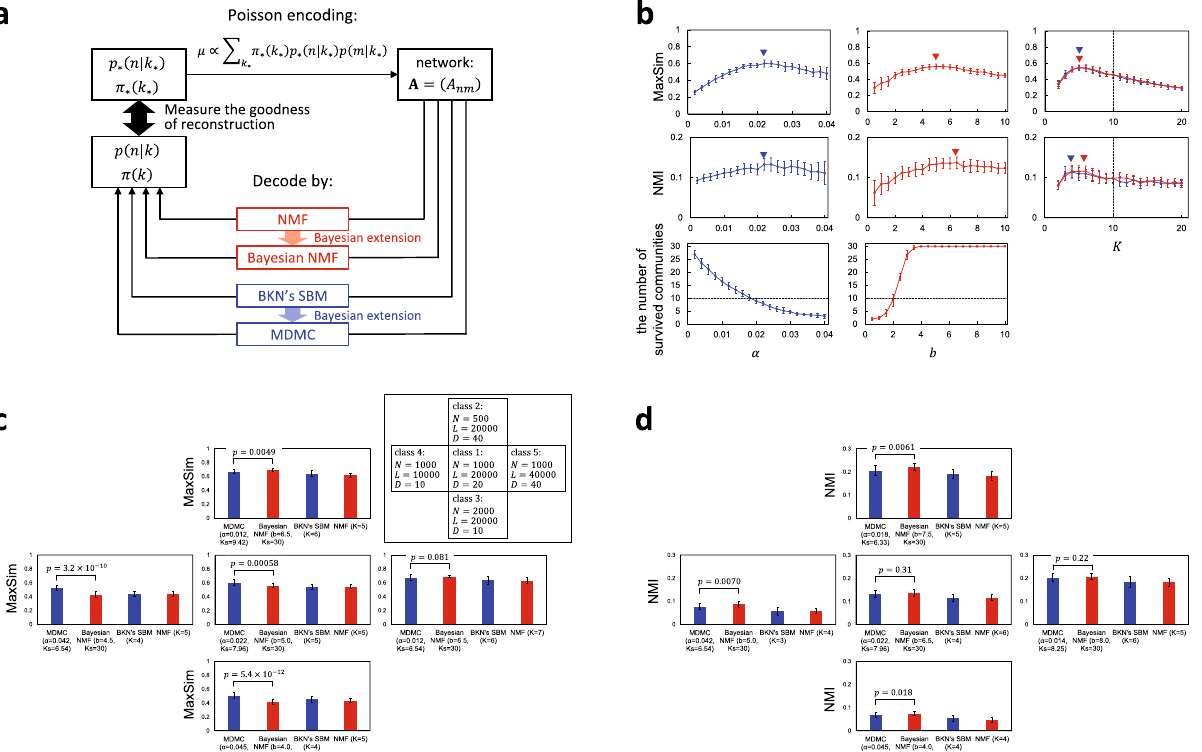
10 Figure 3. The performance of community detection from benchmark networks planted with K ∗ = pervasive communities was compared between MDMC, Bayesian NMF, BKN’s SBM and NMF. ( a ) Schema of our comparative experimental procedure. ( b ) Results for pervasive community detection from benchmark 1000 nodes and L 20,000 undirected links, whereby the density D 20 ). L / N networks of class 1 ( N = = = = MaxSim, NMI and the number of survived communities calculated by MDMC and Bayesian NMF are plotted as functions of α and b in panels of the left and centre columns, respectively. MaxSim and NMI calculated by BKN’s SBM (blue) and NMF (red) are plotted as function of the predefined number K in panels of the right column. Filled inverted triangles in panels of the top and middle rows indicate peak MaxSims and NMIs. Horizontal dashed lines in panels of the bottom row and vertical dashed lines in panels of the right column 10 of planted pervasive communities. ( c ) Peak MaxSims are compared indicate the true number K ∗ = between MDMC, Bayesian NMF, BKN’s NMF and NMF. The centre, top, bottom, left and right panels show 1000, L 20,000, D 20 ), class 2 ( N 500, L 20,000, D 40 ), the results obtained for class 1 ( N = = = = = = 2000, L 20,000, D 10 ), class 4 ( N 1000, L 10,000, D 10 ) and class 5 class 3 ( N = = = = = = 1000, L 40,000, D 40 ) benchmark networks, respectively. ( d ) Peak NMIs are compared between the ( N = = = four methods. The centre, top, bottom, left and right panels show the results obtained for class 1, class 2, class 3, class 4 and class 5 benchmark networks, respectively. Error bars in ( b – d ) indicate standard